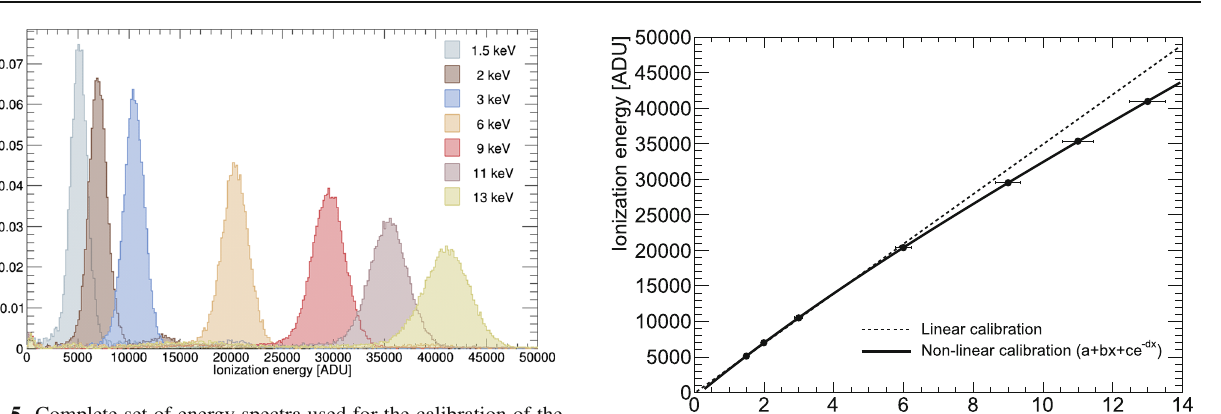
Fig. 5 Complete set of energy spectra used for the calibration of the detector response. The kinetic energy is determined by the Comimac facility.Thecosmicbackgroundhasbeensubtractedbutnocutisapplied 3 . 7% ± 0 . 5% and R ( 3 . 23 keV ) = 3 . 9% ± 0 . 5%, respec-